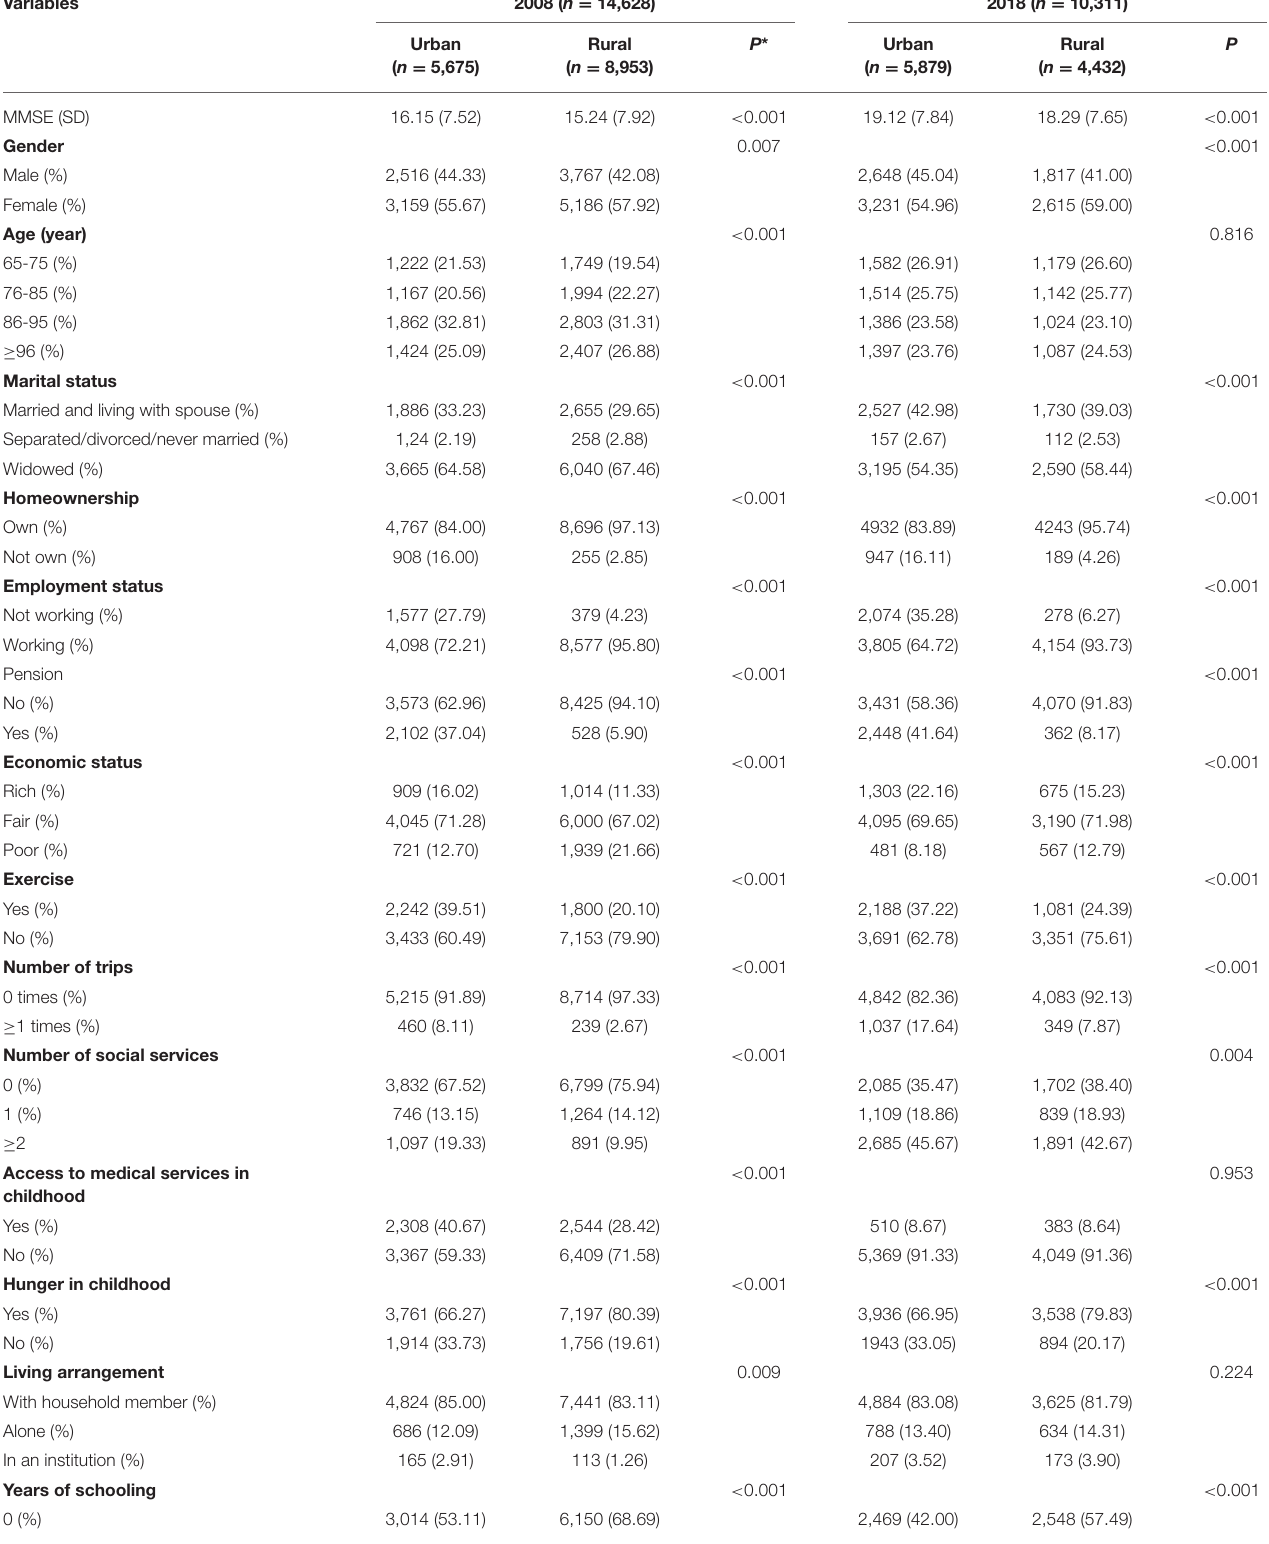
TABLE 1 | Rural-urban difference in MMSE scores and explanatory variables in 2008 and